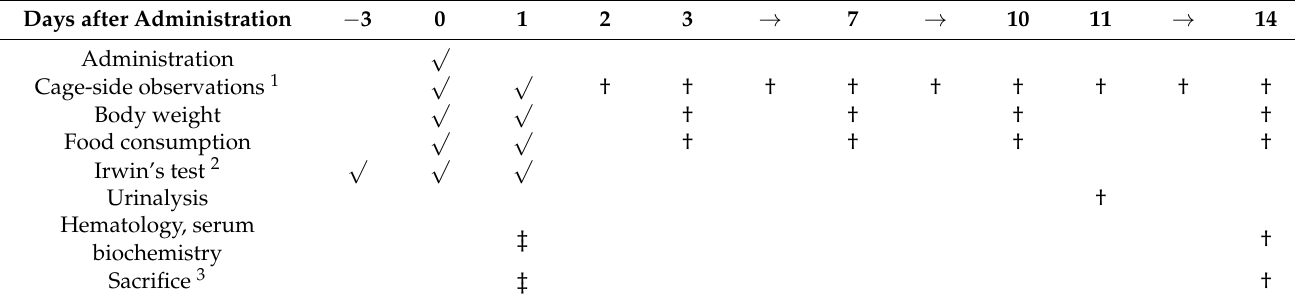
Table 1. Schedule of endpoint collections and study